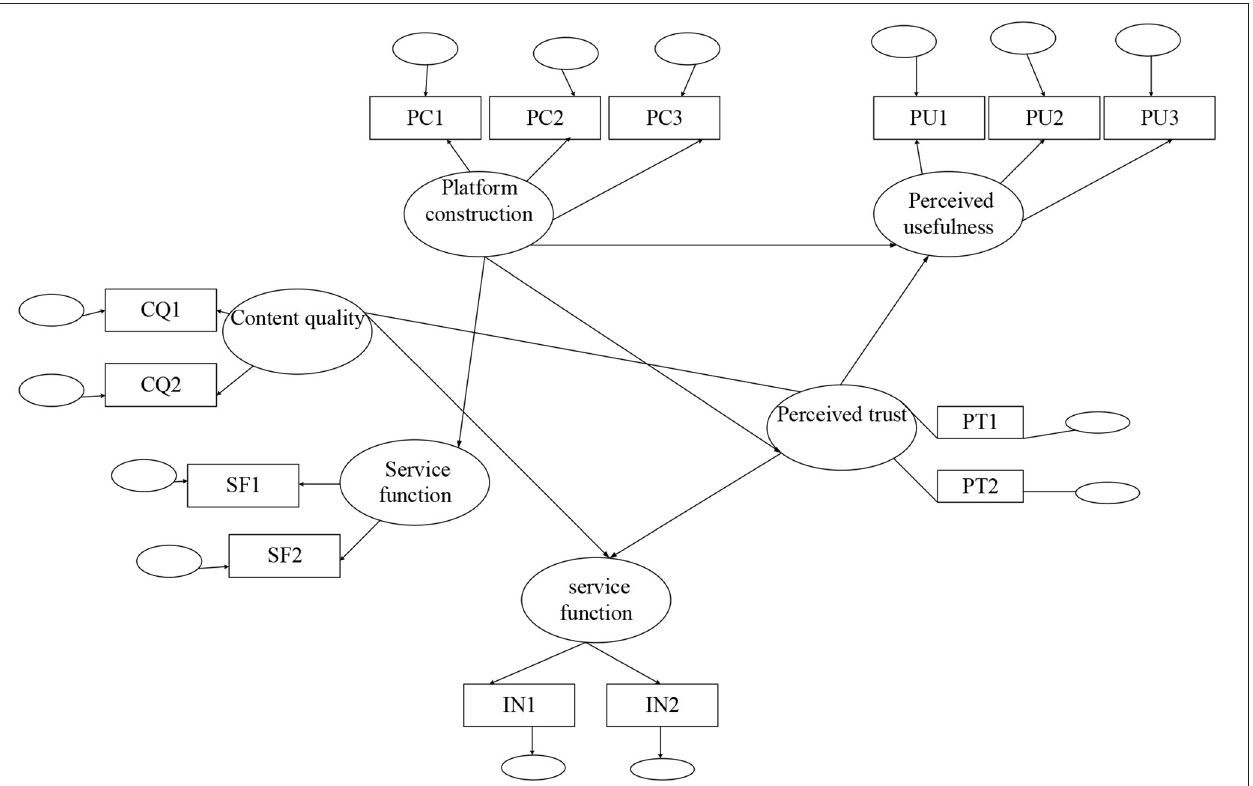
FIGURE 8 | The structure equation of the